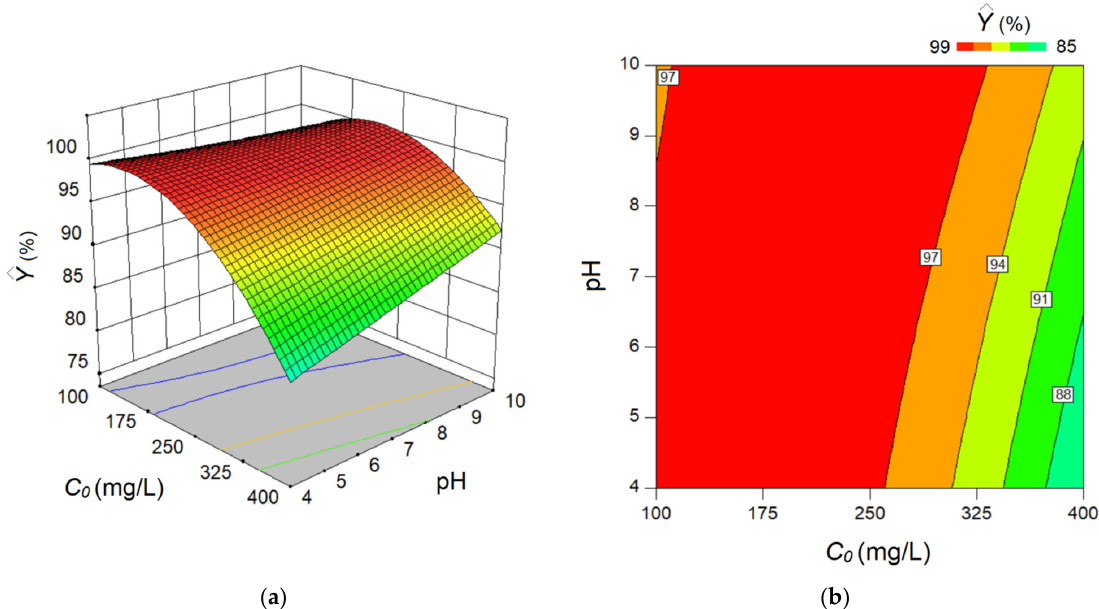
Figure 8. Response surface 3D diagram ( a ) and contour-lines 2D map ( b ) highlighting the mutual effect of factors: C 0 (initial MB concentration) and pH of the aqueous solution, on the estimated response—removal efficiency ( Ŷ , %).